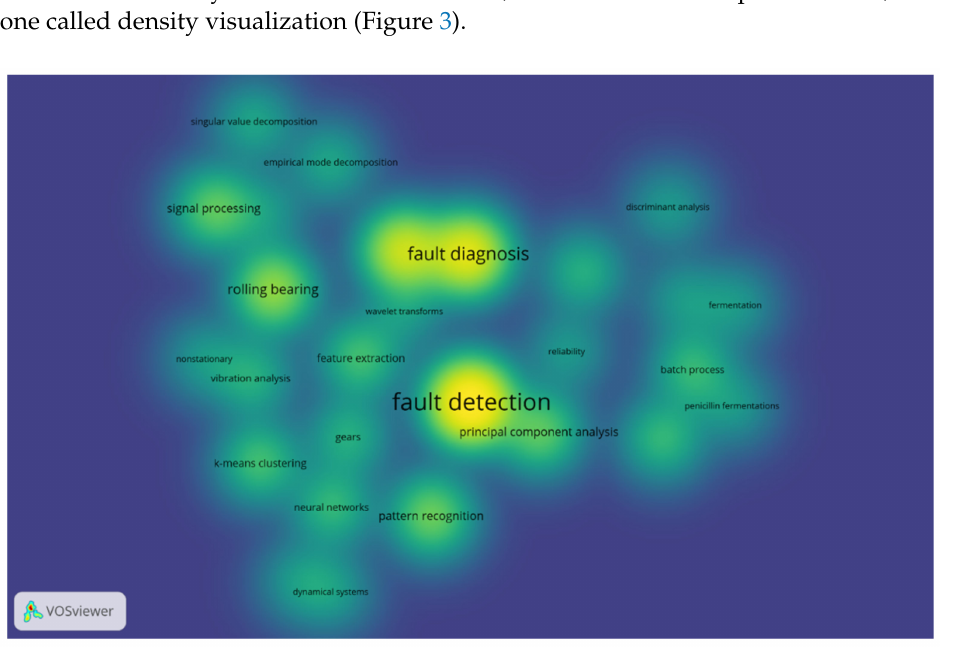
Figure 3. Density